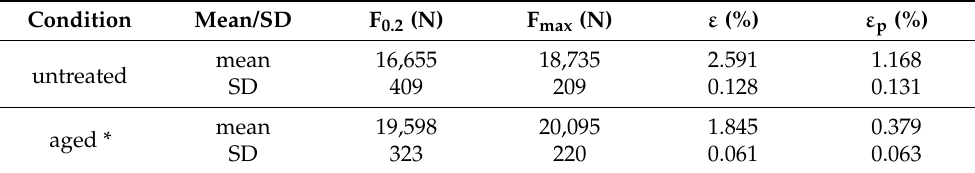
Table 6. Strength and strain parameters of Ø3.6C compact steel cord in untreated and aged conditions. Condition